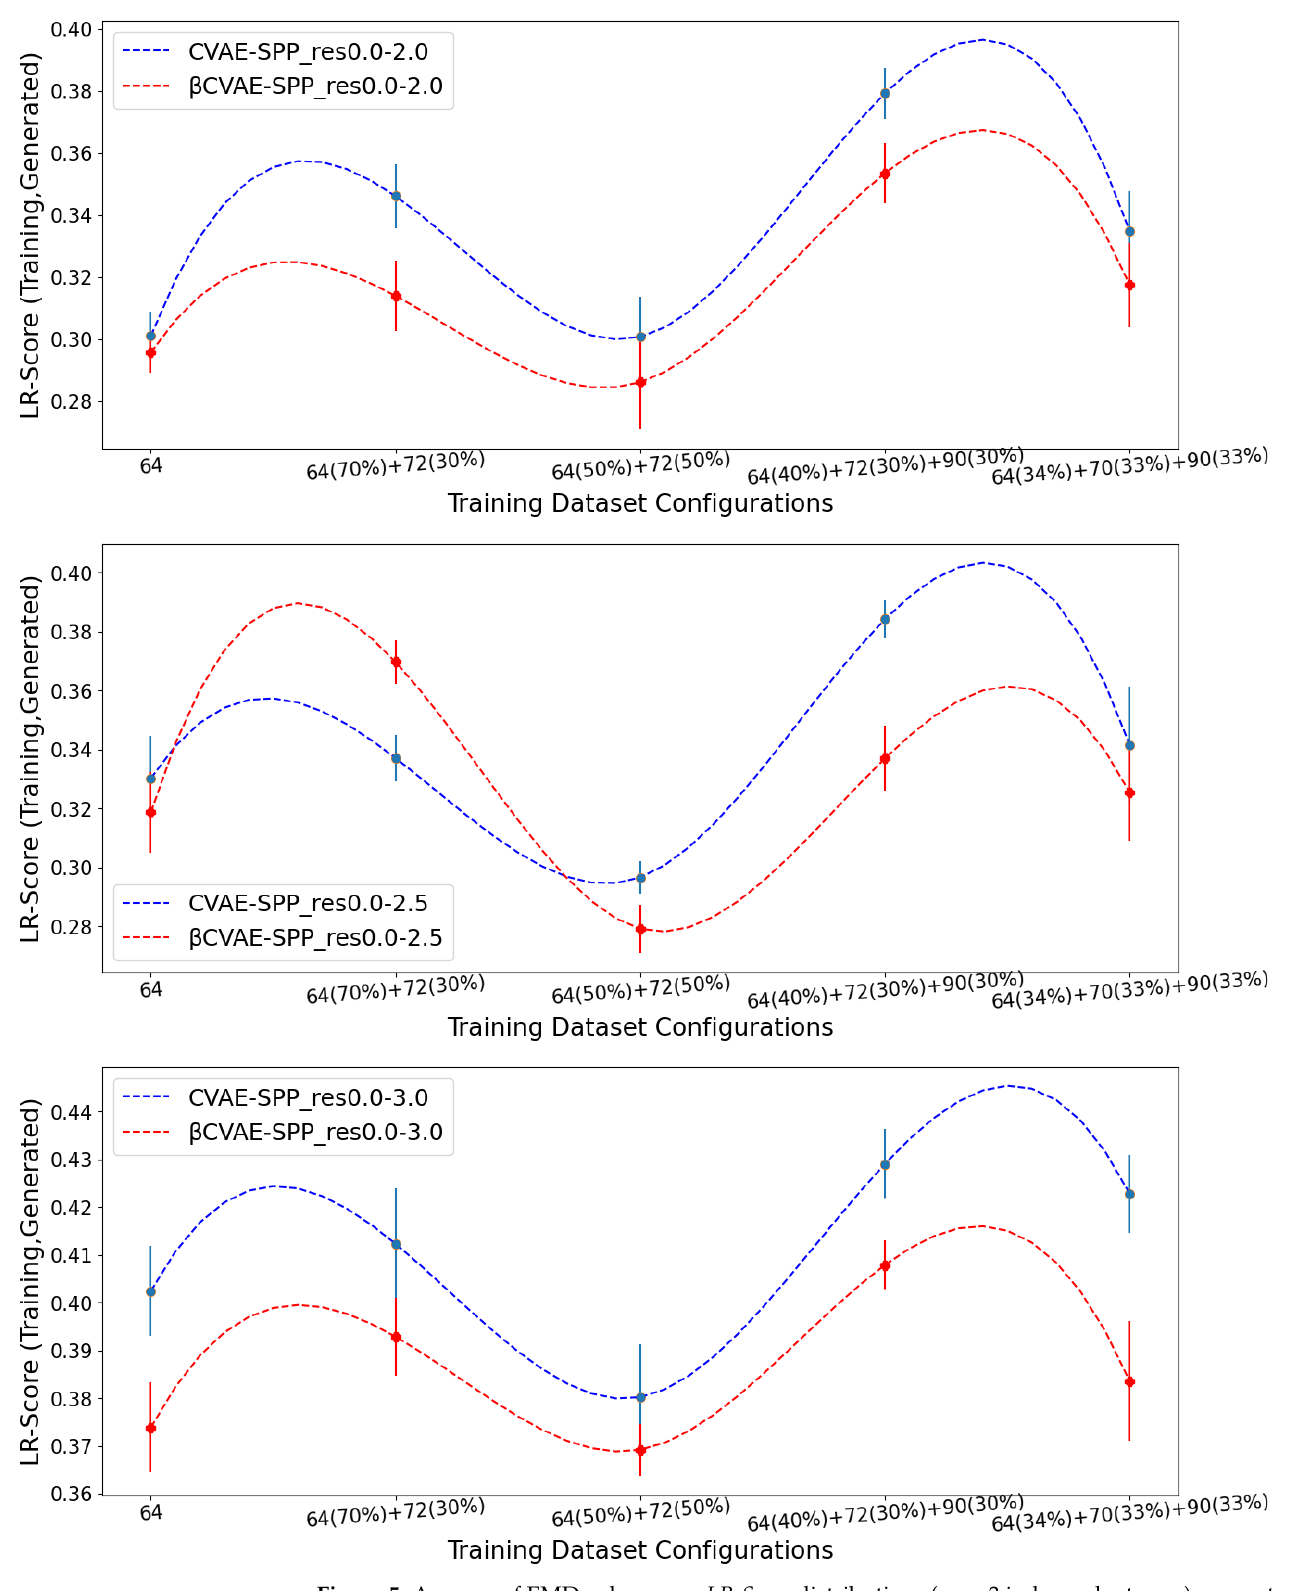
Figure 5. Average of EMD values over LR-Score distributions (over 3 independent runs) computed over generated versus training distance matrices by CVAE-SPP and β CVAE-SPP. Each model is trained on a training dataset configuration ( x axis) of an input dataset. The three panels relate the different input